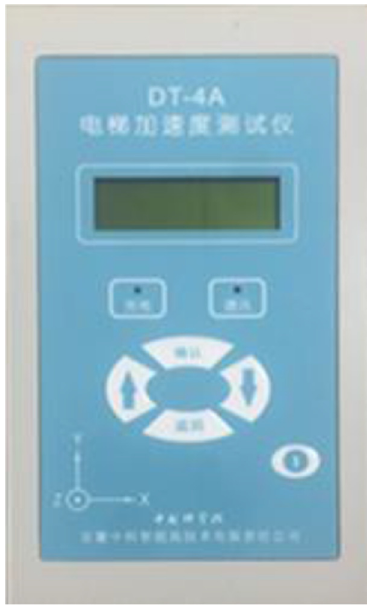
Fig. 6. DT-4A elevator acceleration